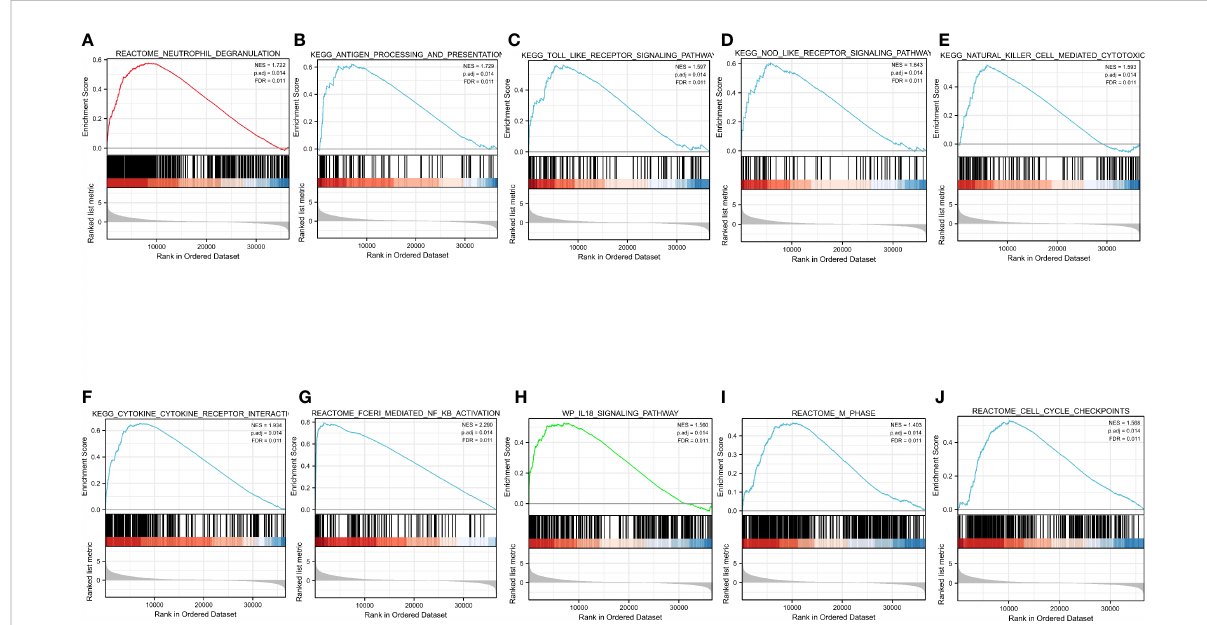
FIGURE 8 Enrichment pathways from Gene Set Enrichment Analysis. (A) Neutrophil degranulation. (B) Antigen processing and presentation. (C) TOLL-like receptor signaling pathway. (D) NOD-like receptor signaling pathway. (E) Natural-killer-cell-mediated cytotoxicity. (F) Cytokine – cytokine receptor interaction. (G) FCERI-mediated NF-kB activation. (H) IL18 signaling pathway. (I) Cell cycle checkpoints. (J) M phase. All the above- mentioned quali fi ed signaling pathways are signi fi cantly enriched in the high-CASP4-expression